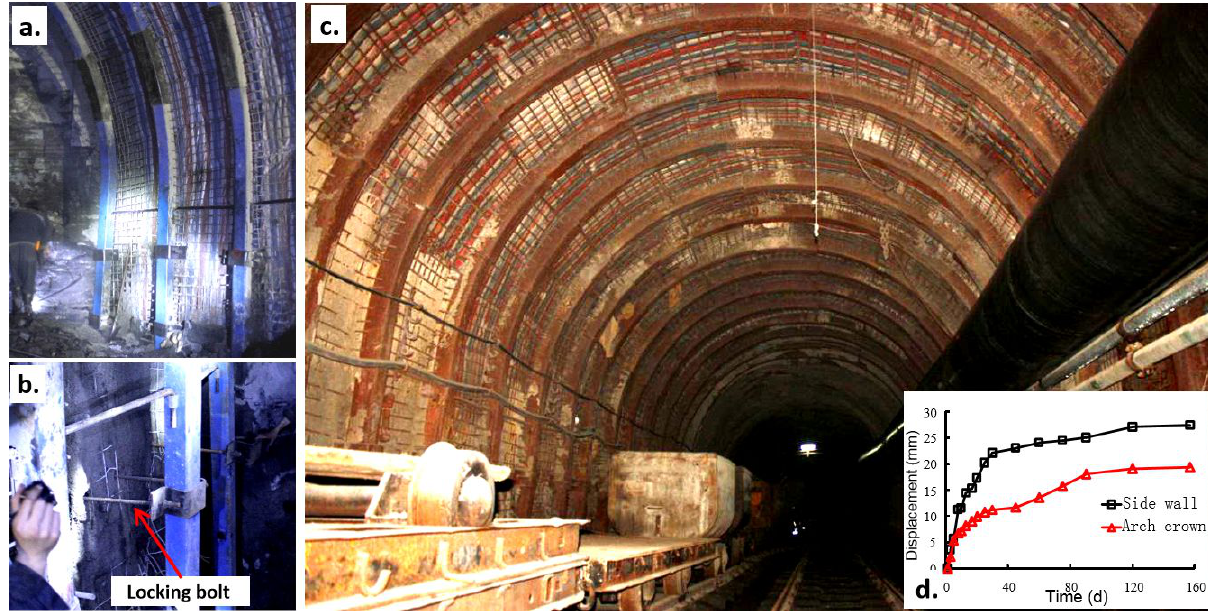
Figure 11: Field practice of the CFST arch support with the arch locking